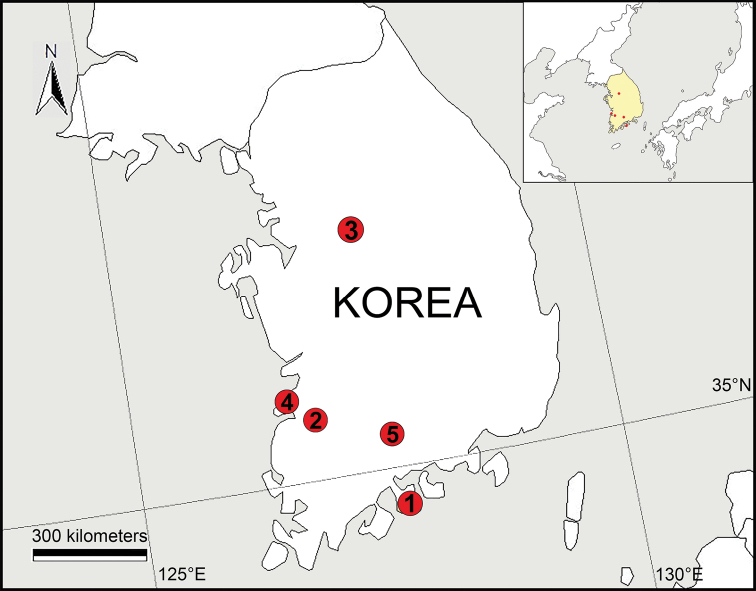
Known distribution records of new leptonetid species from Korea 1Falcileptoneta
dolsan sp. nov. 2Falcileptoneta
naejangsan sp. nov. 3Longileptoneta
buyongsan sp. nov. 4Longileptoneta
byeonsanbando sp. nov. 5Longileptoneta
jirisan sp. nov.